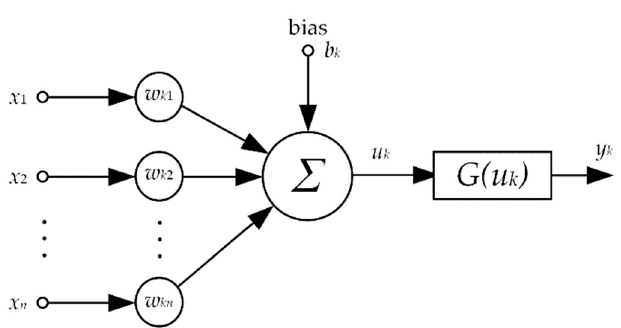
Figure 11. Neuron model diagram [20].